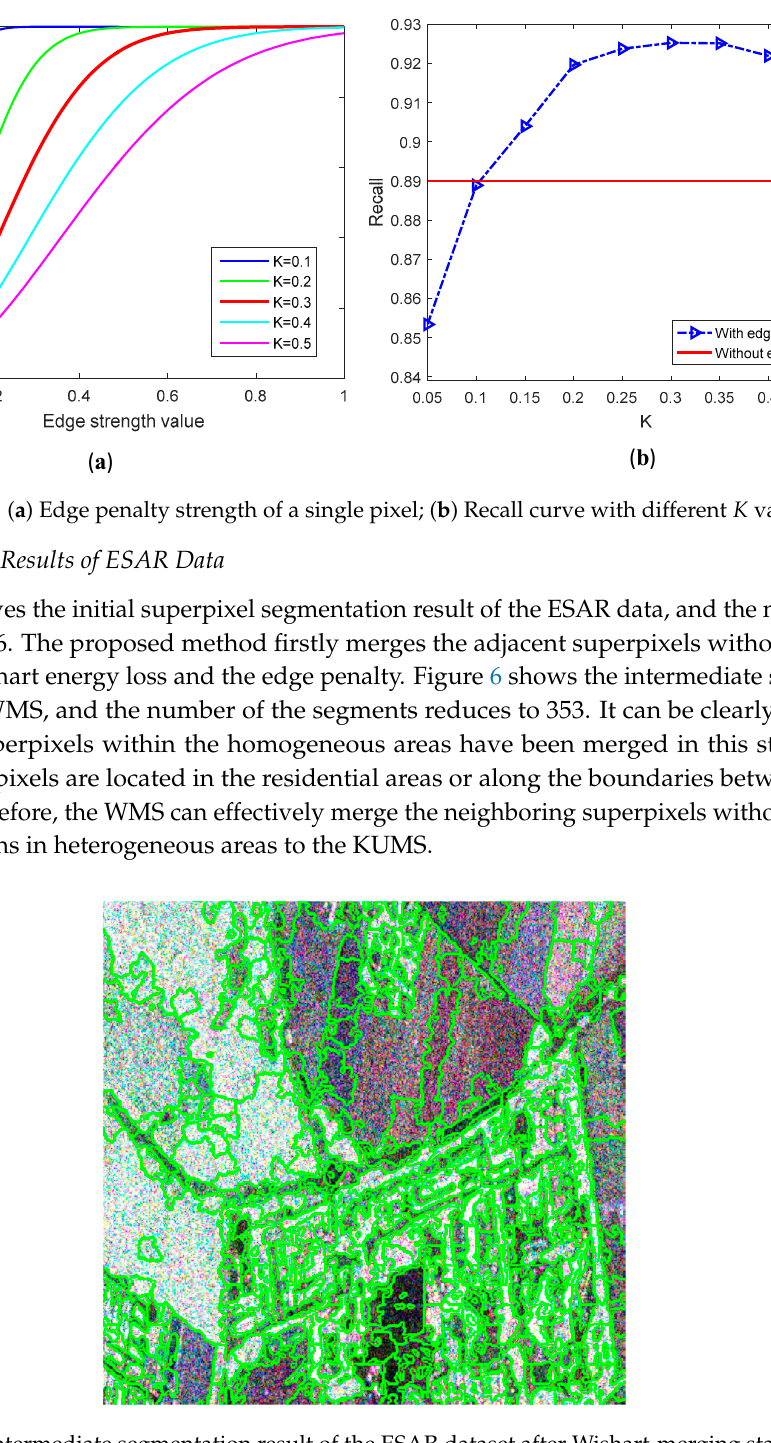
Figure 6. The intermediate segmentation result of the ESAR dataset after Wishart-merging stage (WMS).